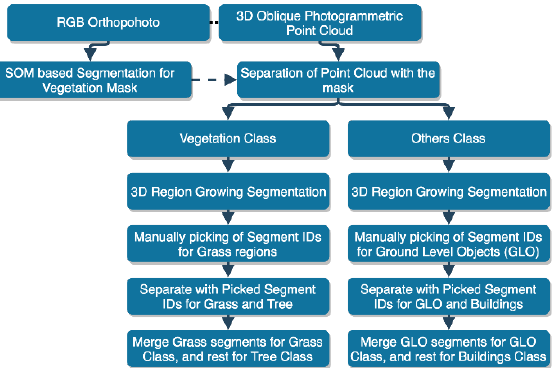
Figure 2. The developed methodology, based on orthoimage and point cloud processing, to identify buildings and geometrically model